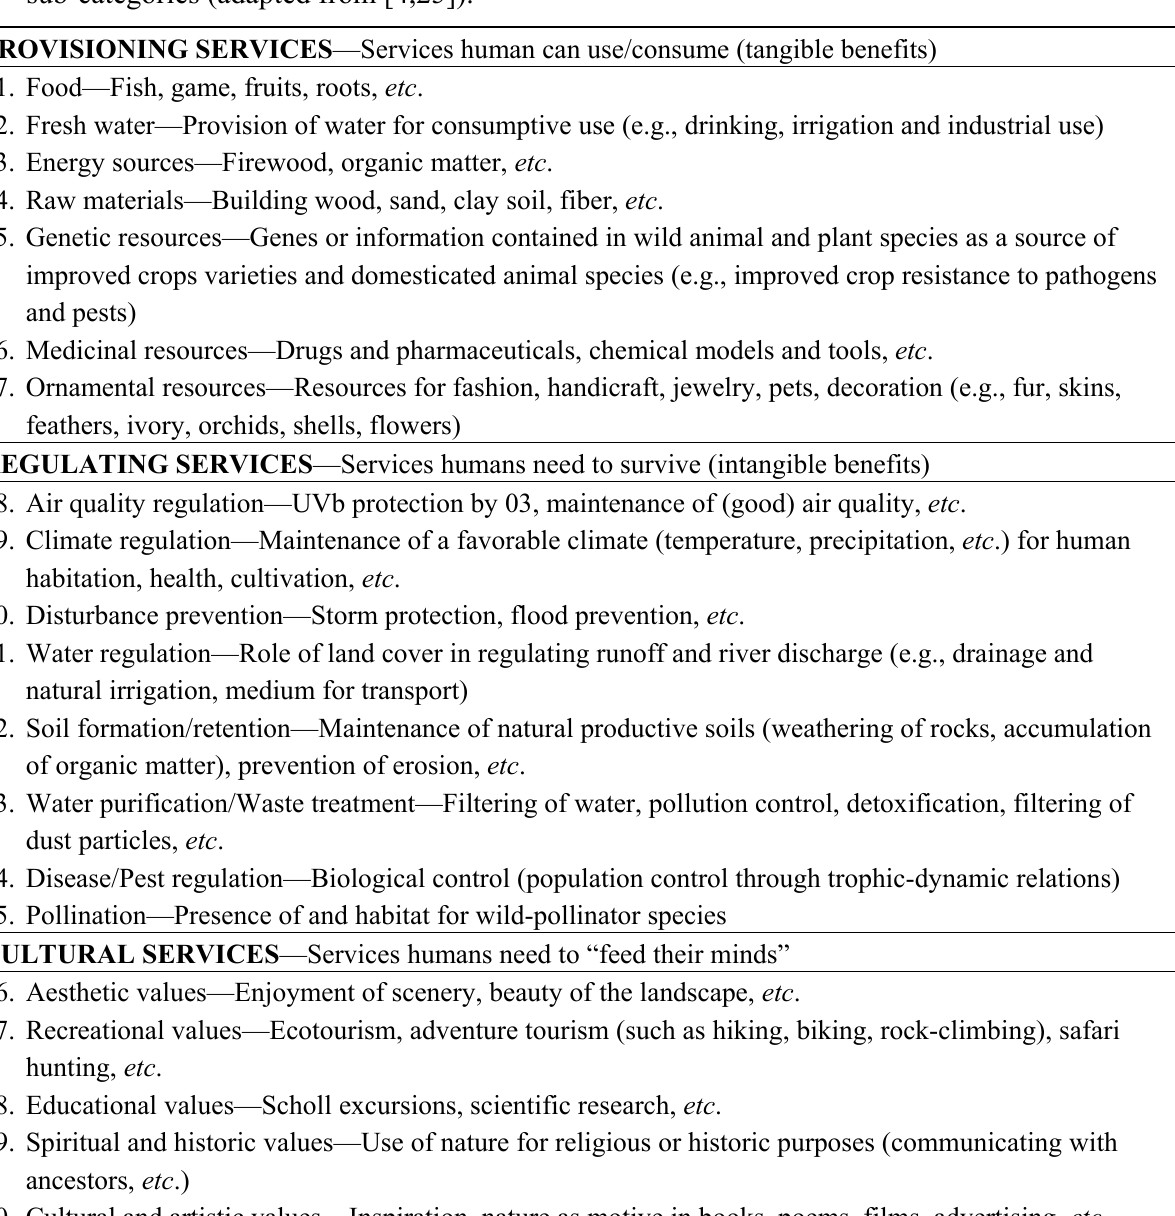
Table 2. Detailed framework of the Ecosystem Services (ES) sub-index: categories